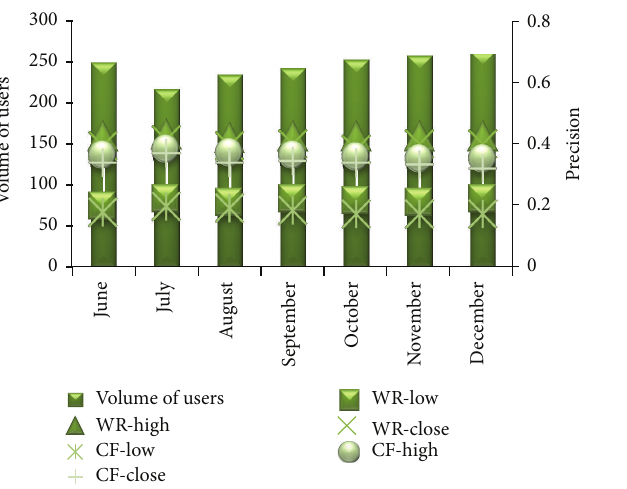
Figure 14: WebBluegillRecom-annealing dynamic recommender system (WR) is compared to standard collaborative filtering (CF) systemon coverage fordifferentvolume ofusersin differentmonths.